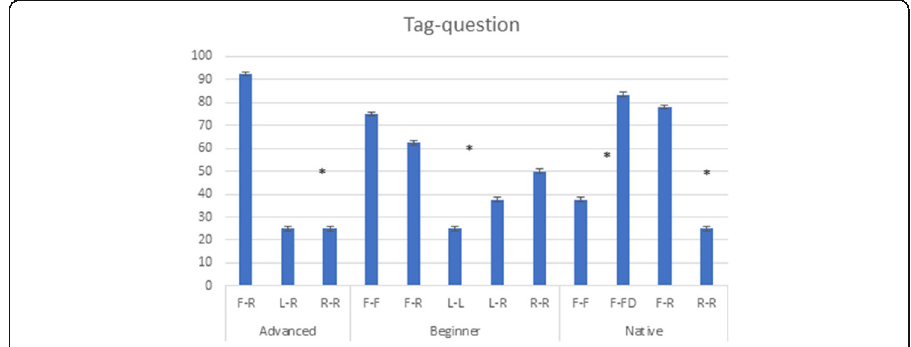
Fig. 4 Mean proportion of final tunes of tag- questions by speaker groups. Y-axis: mean percentage. The symbol * means significant at p <